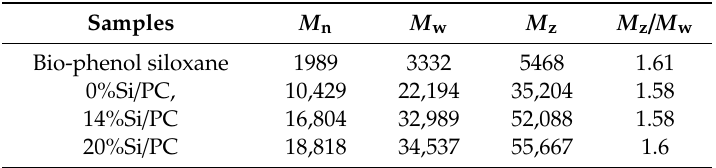
Table 1. Molecular weight and its distribution index of bio-phenol polysiloxane/polycarbonate (Si/PC) copolymer.